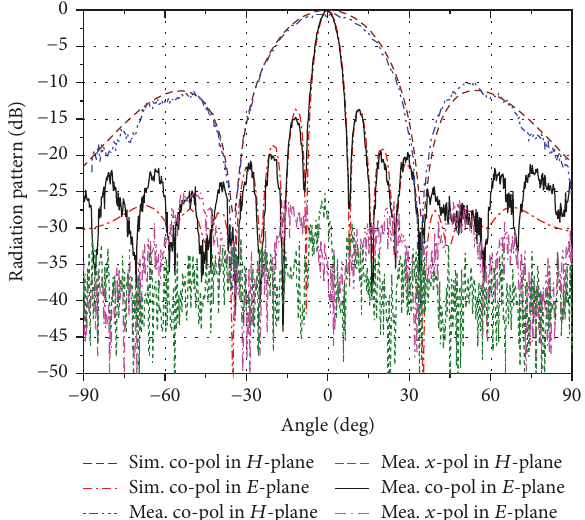
Figure 10: Simulated and measured normalized radiation pattern of the 2 × 8 antenna array at 35 GHz.